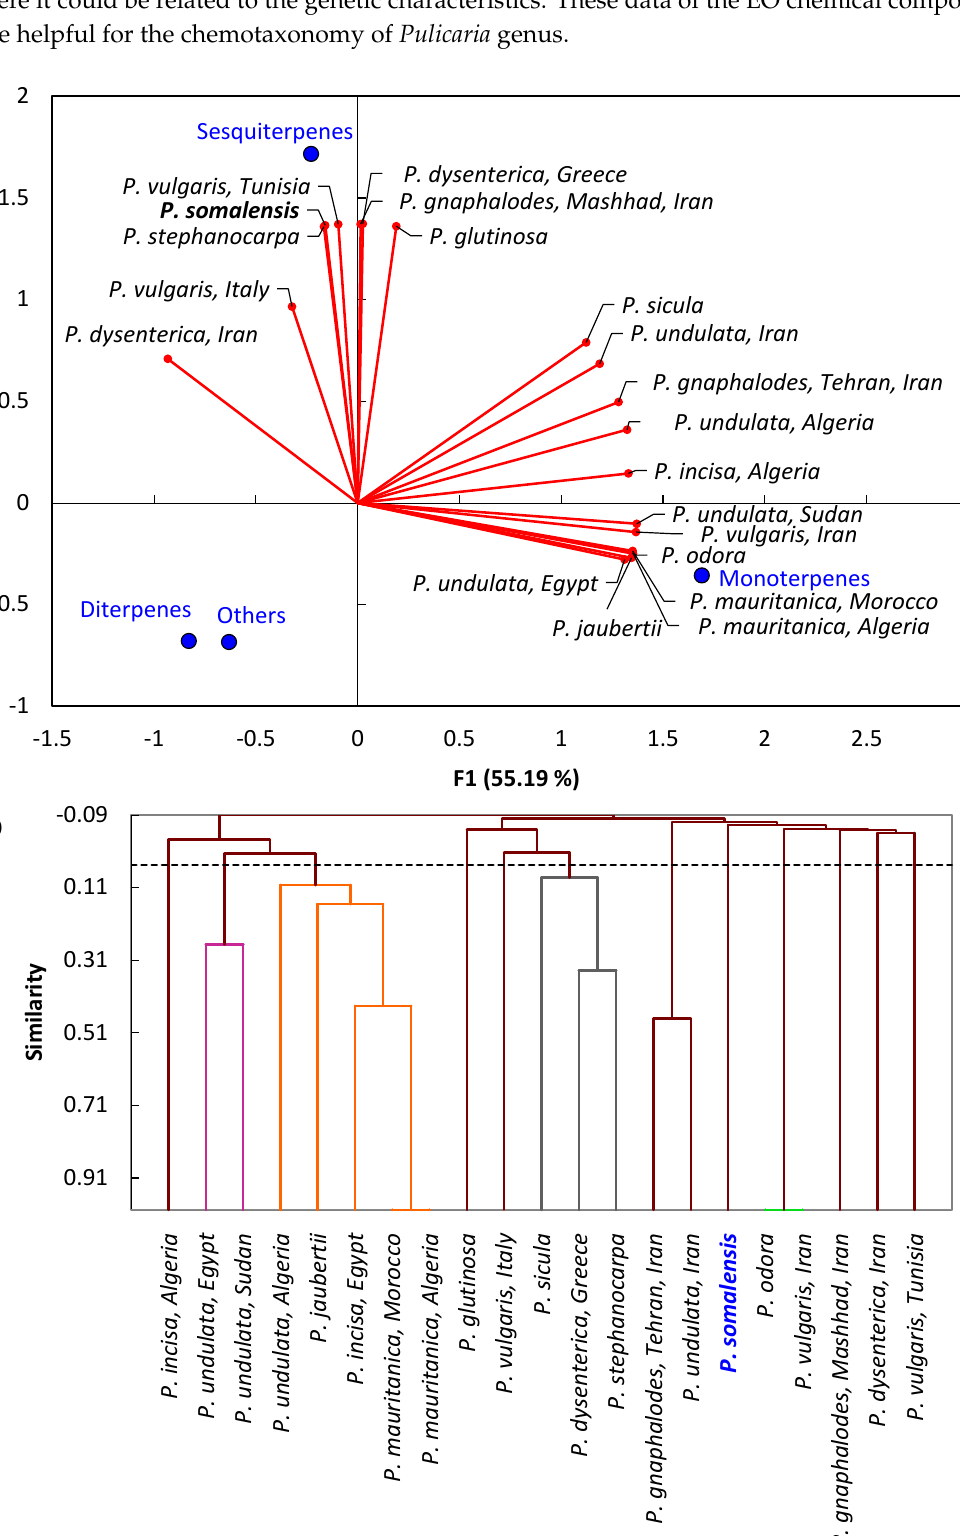
Figure 2. ( a ) Principal component analysis (PCA) based on the chemical classes of the essential oil, and ( b ) agglomerative hierarchical clustering (AHC) based on the major chemical compounds of the EO of Pulicaria somalensis (Shie) and other reported Pulicaria species.